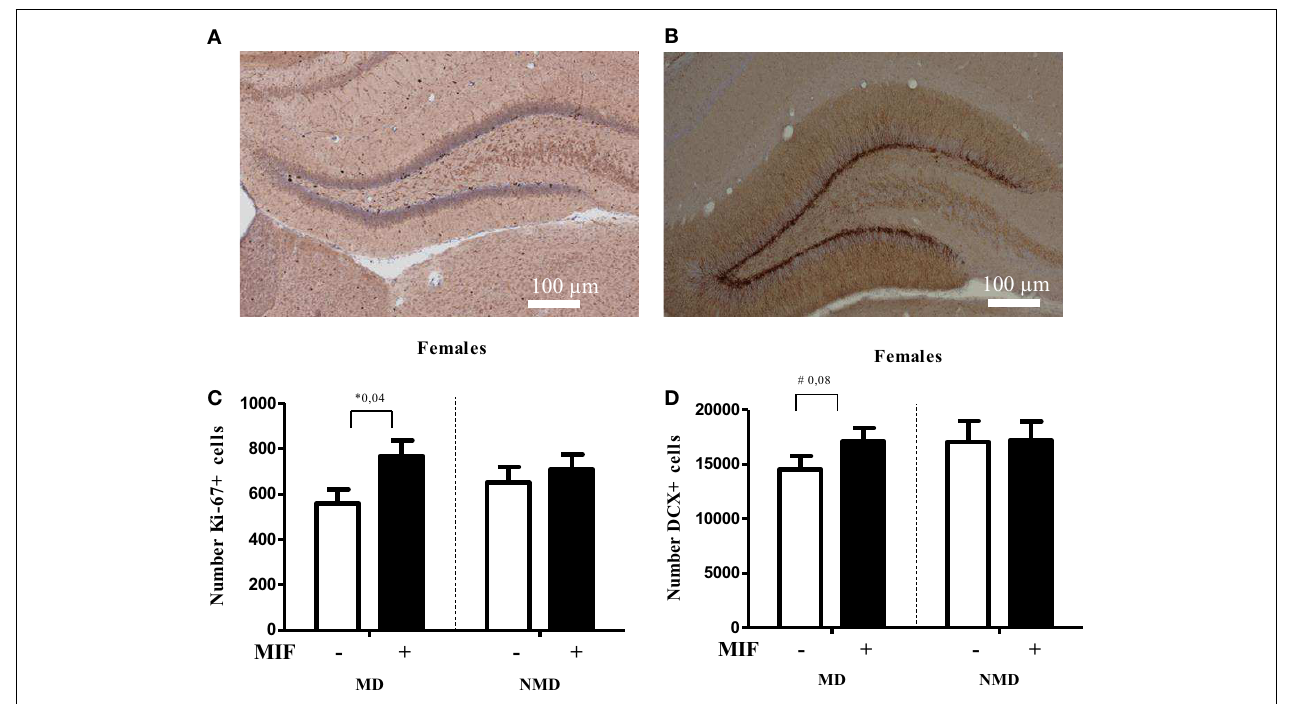
vehicle. MIF had no effect in non-deprived (NMD) rats. No significant differences between the experimental groups were seen in the dentate as a whole (data not shown). For each animal, we counted the number of Ki67-positive cells in every 10th section and from this the total number of Ki67-positive cells per hemisphere was inferred. All bars represent the mean + SEM per group ( n = 7–9 animals per group). (D) In the supra-pyramidal blade, a trend ( p = 0.08) toward a significant increase in the number of DCX-positive cells in MD female rats treated with MIF vs. those treated with vehicle was observed. Mifepristone did not alter neurogenesis at all in NMD rats.Though the percentage change in the infrapyramidal blade and the dentate gyrus as a whole showed a comparable pattern, these differences were not significant ( p > 0.1, data not shown). For each animal, we counted every 10th section sampled in an unbiased stereological manner, yielding up to a total of nine sections per animal.We then expressed the average number of DCX-positive cells per section per animal. All bars represent the mean + SEM per group ( n = 11–12 animals per